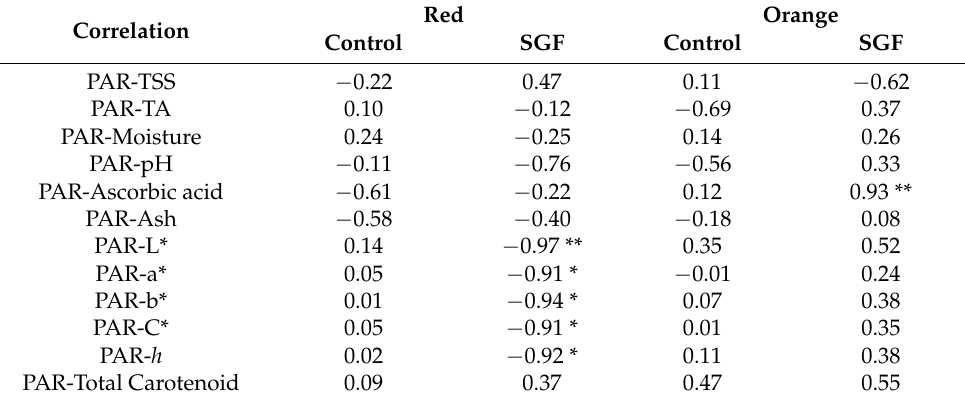
Table 2. Pearson’s correlation coefficient analysis of photosynthetically active radiation (45 to 65 DAP) with fruit quality indexes in mature ripe fruit (65 DAP). The correlation coefficient and probability values were analyzed by R using “Hmisc” package. Data was analysed from multiple fruits ( n = 12). Statistical analysis was performed using a one-way ANOVA (*: p ≤ 0.05 and **: p ≤ 0.01). Abbrevia- tions: Smart glass film (SGF), days after pollination (DAP), total soluble solids (TSS), titratable acids (TA), photosynthetically active radiation (PAR), chroma (C*), hue angle ( h ), lightness (L*),